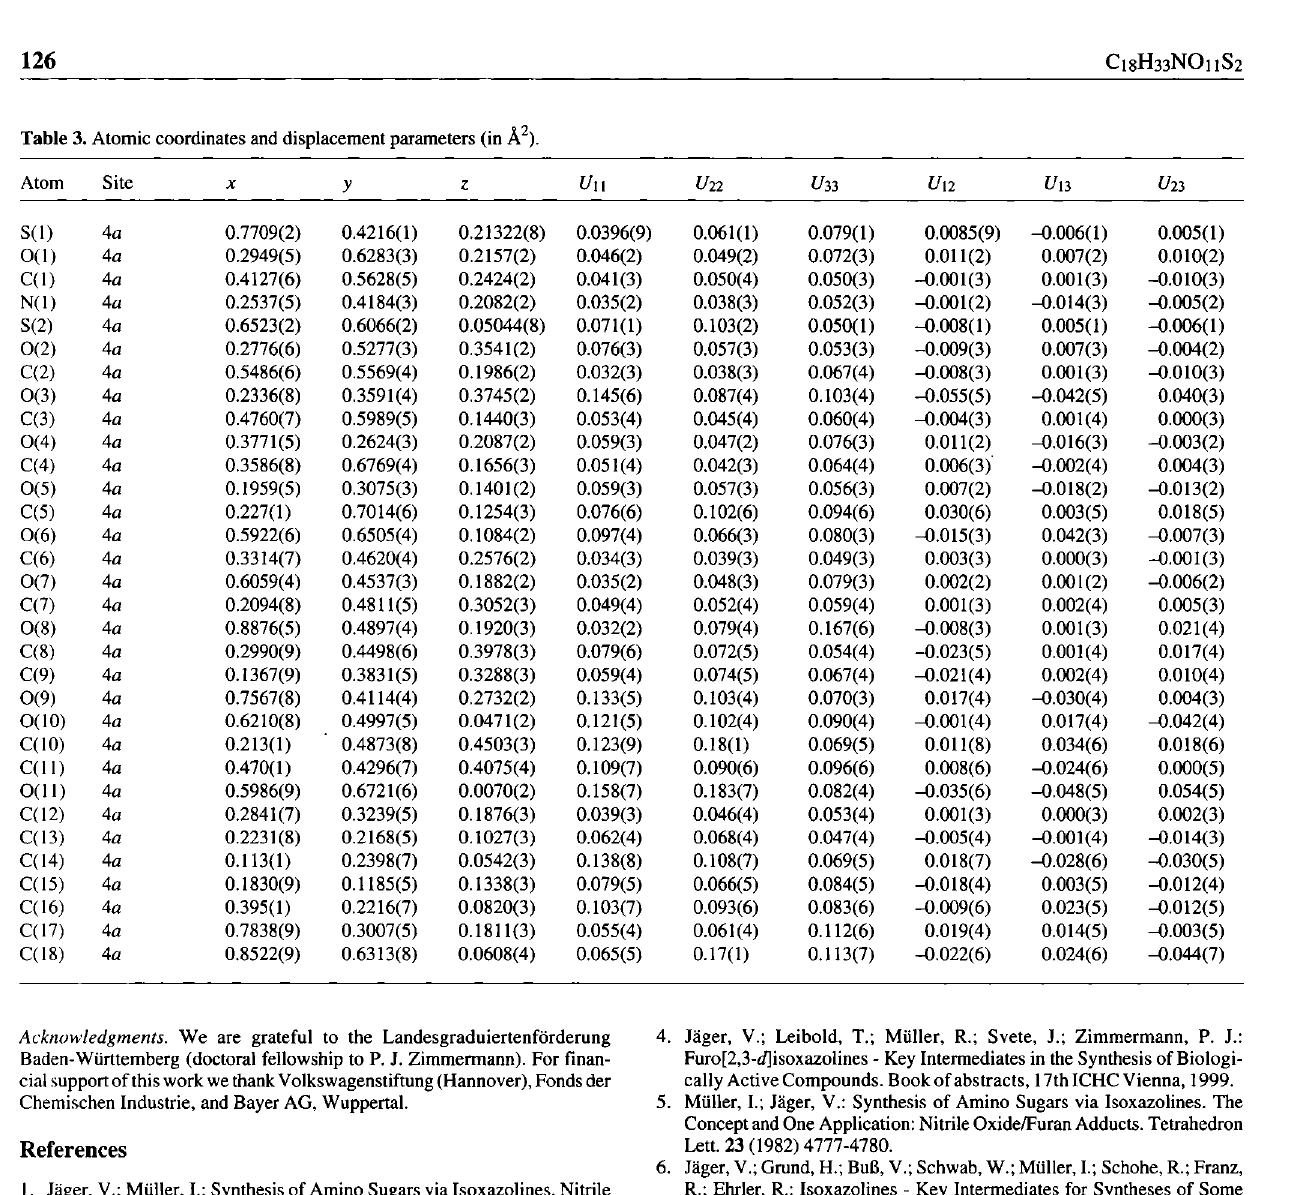
Table 3. Atomic coordinates and displacement parameters (in A 2